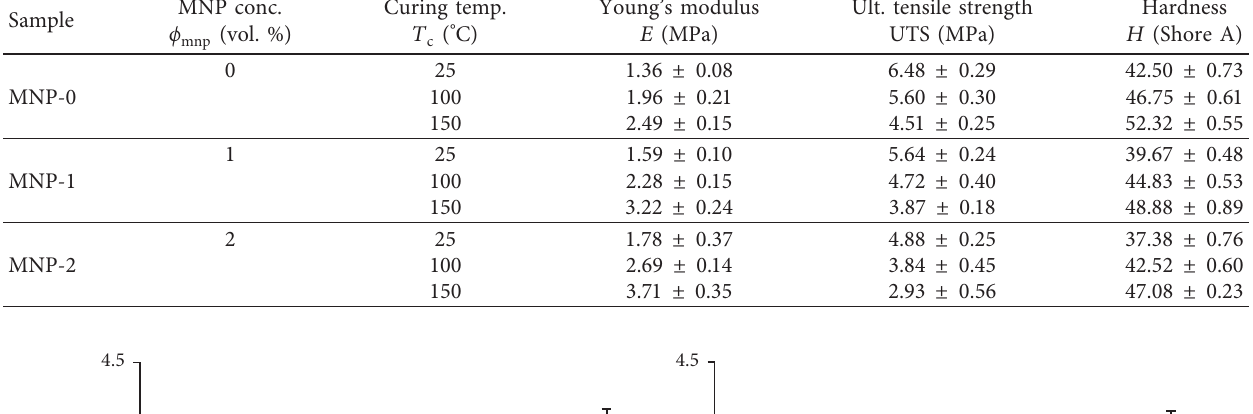
Table 2: Summary of the mean ( ± SEM), Young’s modulus ( E ); ultimate tensile strength (UTS), and hardness (Shore A) ( H ) of samples MNP-0, MNP-1, and MNP-2 cured at 25, 100, and 150 ° C.